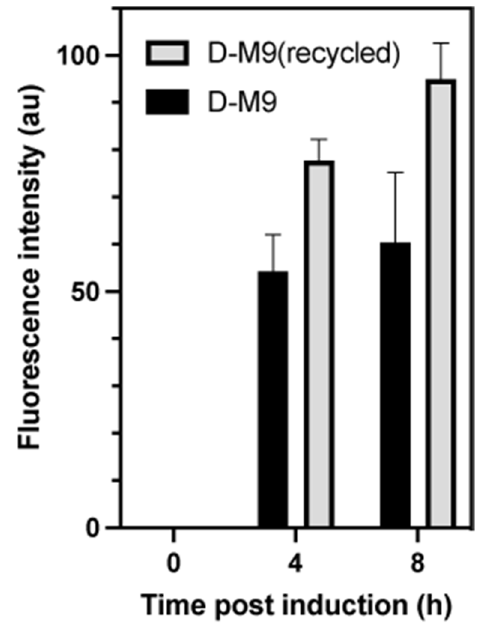
Figure 4. Protein production using E. coli DAP1(DE3). Absolute fluorescence intensities (arbitrary units) in cells harvested at different time points after inducing expression of the gene encoding sfGFP. E. coli DAP1(DE3) was grown at 37 °C in D-M9 and D-M9 prepared with recycled D 2 O. Protein expression was induced at an OD 600 of ~1. Each histogram represents three biological replicates. Error bars represents the standard error of the mean.